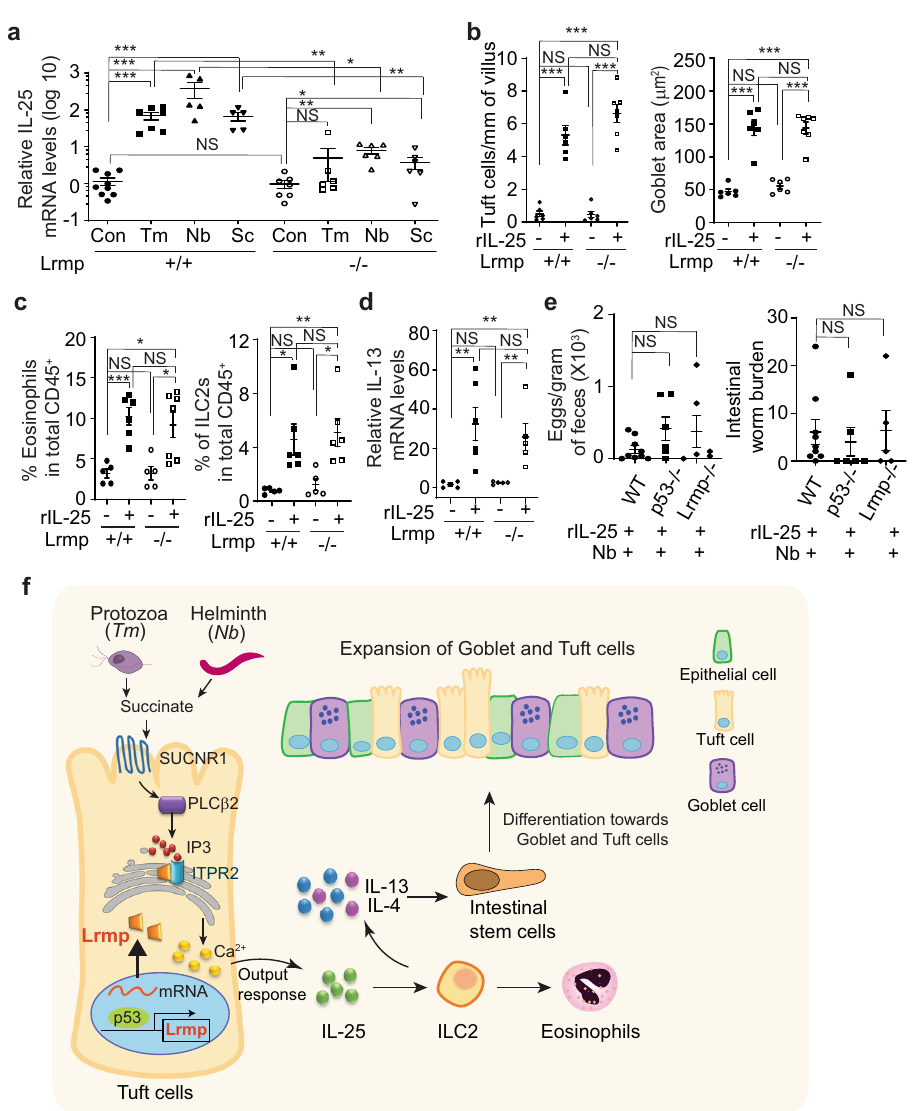
Fig. 6 rIL-25 administration restores the type 2 immune response in Lrmp − / − mice and rescues the impaired ability to expel Nb in p53 − / − and Lrmp − / − mice. a Relative IL-25 mRNA levels in the intestinal epithelium of naïve mice, mice infected with Tm or Nb , and succinate-treated mice. b – d Administering rIL-25 restored the type 2 immune response in Lrmp − / − mice. The expansion of tuft and goblet cells ( b ), the population of eosinophils and ILC2s ( c ), and relative IL-13 mRNA levels ( d ) were examined after administering rIL-25 (0.5 µ g/day; i.p .) for 7 days in Lrmp + / + and Lrmp − / − mice. e rIL- 25 promoted Nb clearance in p53 − / − and Lrmp − / − mice. Mice were infected with Nb at day 0 and treated with rIL-25 every 2 days. Egg counts (left) and intestinal worm burden (right) were quanti fi ed at 7 d.p.i. f Schematic illustration of the role of p53-Lrmp signaling in the intestinal type 2 immunity towards parasitic infections. Data are presented as mean ± SEM. Each dot represents a mouse. n = 5 – 8/group. * p < 0.05; ** p < 0.01; *** p < 0.001; NS: non- signi fi cant, two-tailed Student ’ s t